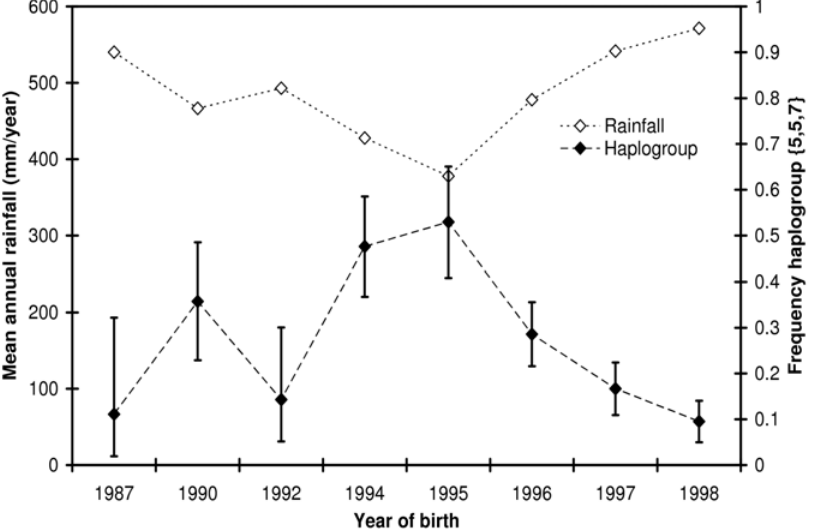
Figure 3. Negative correlation between frequency haplogroup {5,5,7} in KNP and rainfall in the three years before birth. Error bars: standard error ( ffiffiffiffiffiffiffiffiffiffiffiffiffiffiffiffiffiffiffiffiffiffi p (1 { p ) = N p ), except for the two lowest data points in which the haplogroup was observed only once or twice. Here they correspond to a chance $ 84% of sampling # 1 or 2 (positive error bar) or $ 1 or 2 haplogroups (negative error bar). Years of birth 1987, 1990, 1992 and 1994 consist of pooled years because of the small sample size (with the x axis corresponding to the average year of birth). Years of birth were pooled with similar amounts of rainfall in the preceding three years (difference , 69